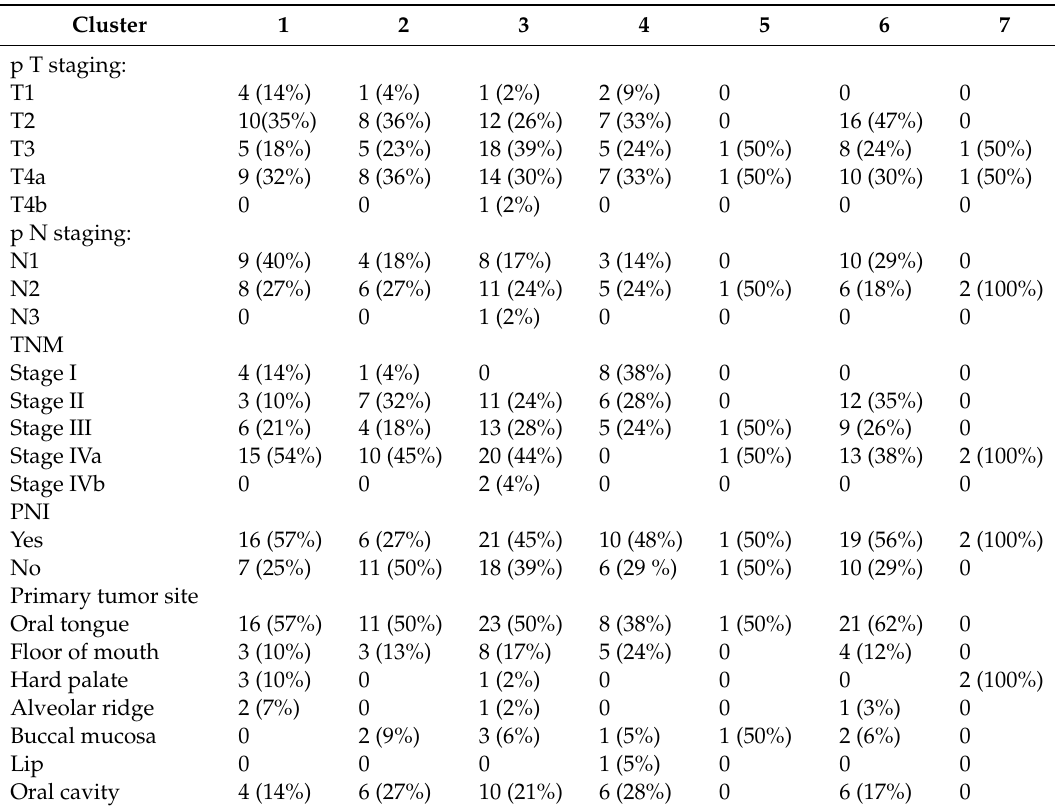
Table4. Clustersanalysis: Thetableshowsthepathologicaldatacharacterizationoftherevealedclusters.